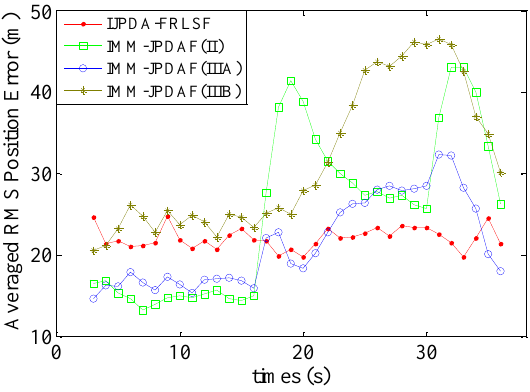
Figure 10. The estimated error for the target I. Information 2018 , 9 , x FOR PEER REVIEW